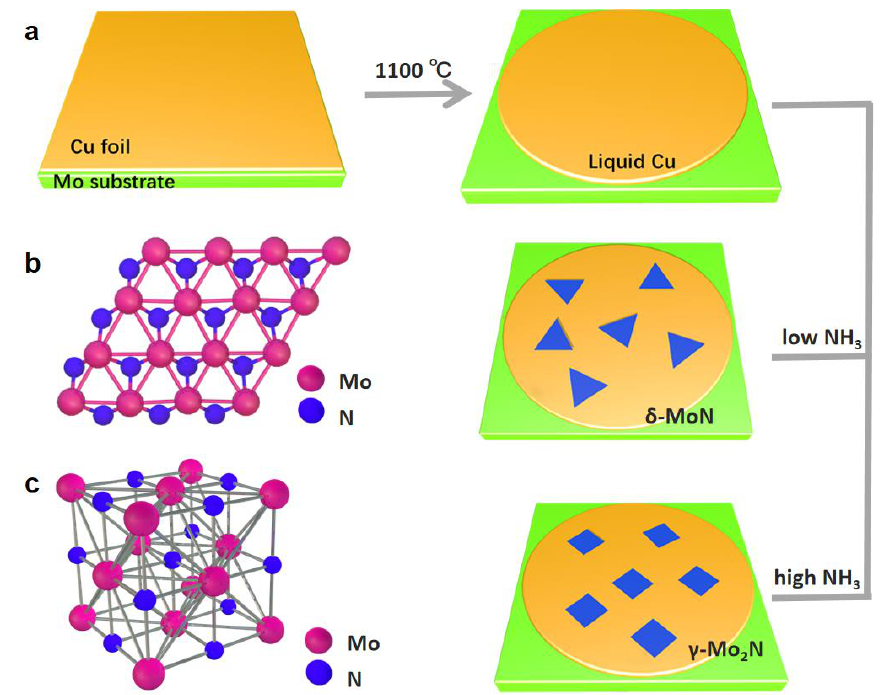
Figure 1. Schematic showing the Mo x N y crystals with different phases grown on the liquid Cu substrate. ( a ) The preparation of liquid Cu substrate and CVD growth of triangle δ -MoN and square γ -Mo 2 N crystals. At lower NH 3 gas flow, δ - MoN grows into triangle crystals. But square γ -Mo 2 N crystals are grown at higher NH 3 gas flow. ( b ) Crystal diagram of δ -MoN flakes. ( c ) Crystal diagram of γ -Mo 2 N flakes.